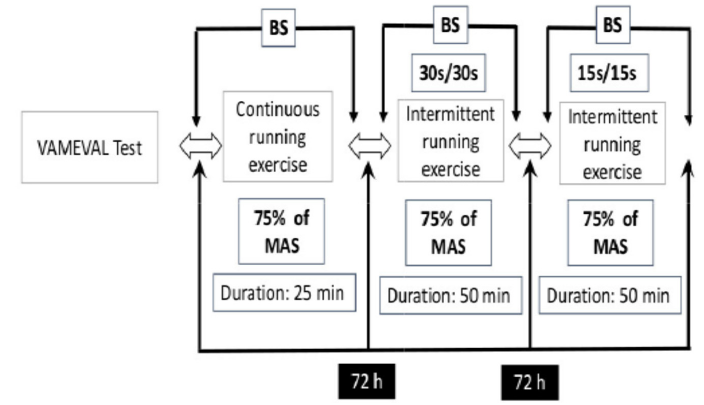
Figure 1. Protocol design. BS: blood sample; MAS: maximal aerobic